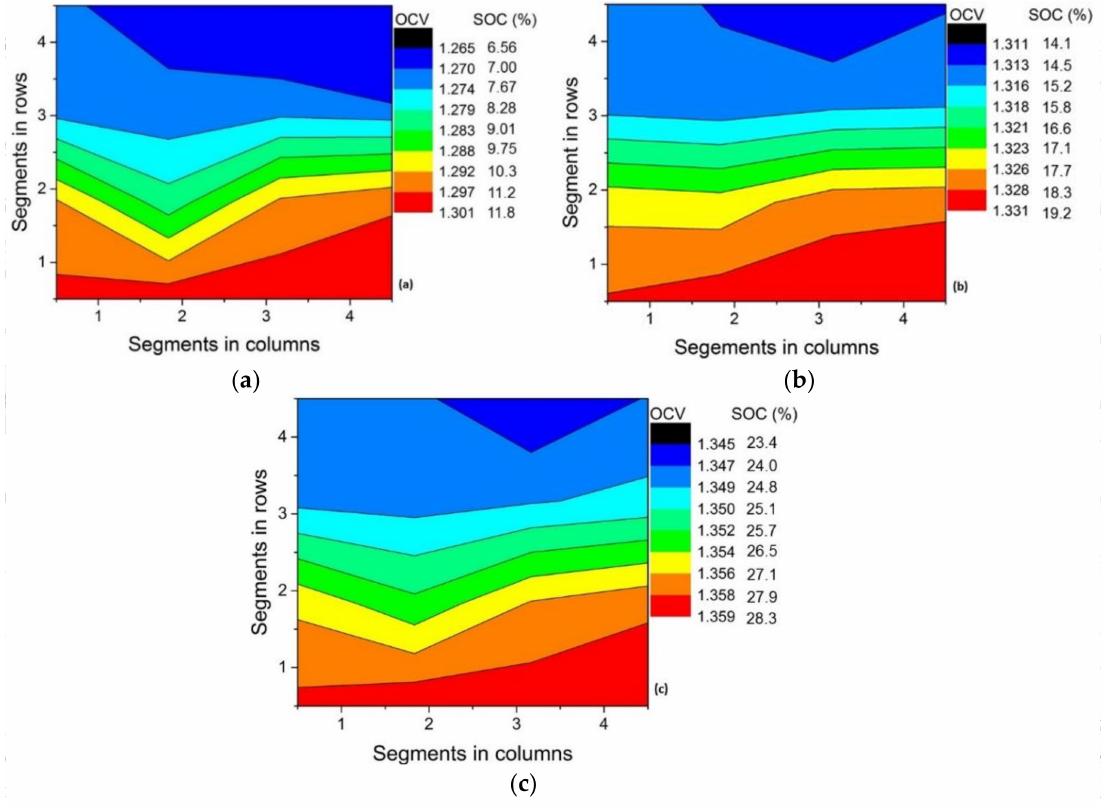
Figure 5. OCV/SOC contours at 5 s after termination of discharge at current densities of ( a ) 150 mA cm − 2 , λ = 0.7 ( b ) 120 mA cm − 2 , λ = 0.85 and ( c ) 80 mA cm − 2 , λ = 1.3. The flow rate was kept constant at 16 mL min − 1